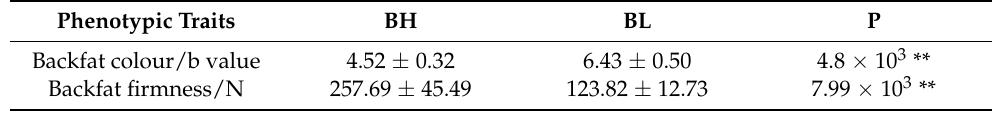
Table 1. The phenotypic values of backfat quality of BH and BL groups. Phenotypic Traits BH BL Backfat colour/b